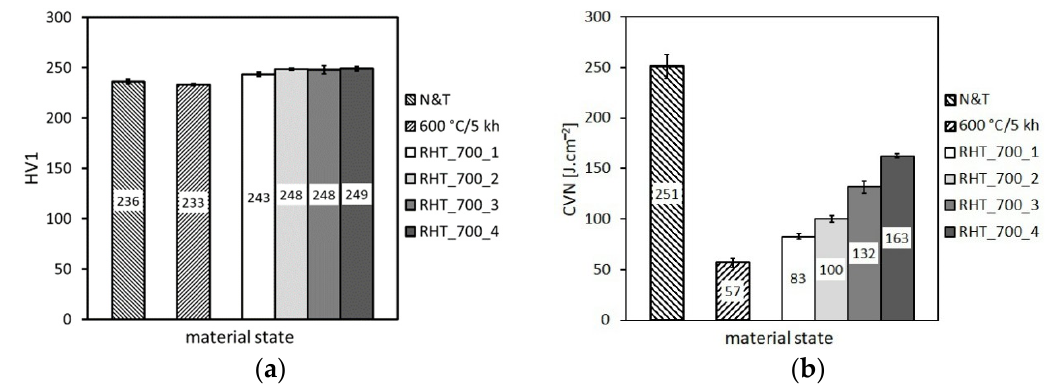
Figure 12. The effect of various heating up and cooling down conditions of the rejuvenation heat treatment at 700 °C for 1 h on ( a ) total elongation and ( b ) reduction of area.